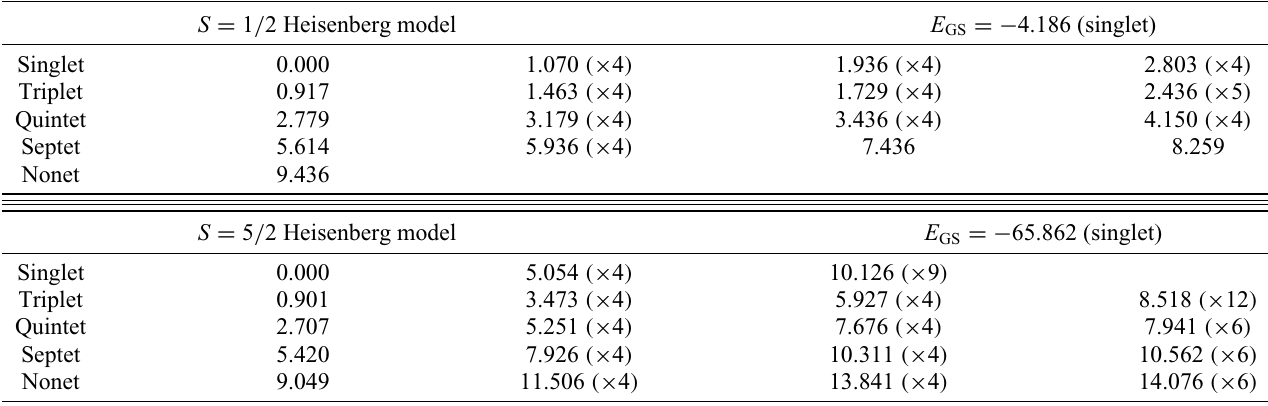
TABLE II. The excitation energy levels of the S = 1 / 2 and S = 5 / 2 Heisenberg models for the P and/or Fe-Mo–cofactor cluster. S = 1 / 2 Heisenberg model